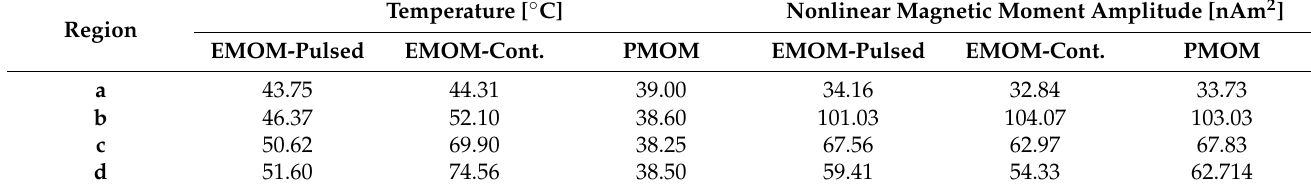
Table 1. Temperatures and nonlinear magnetic moment amplitudes of the three measurement modes at different